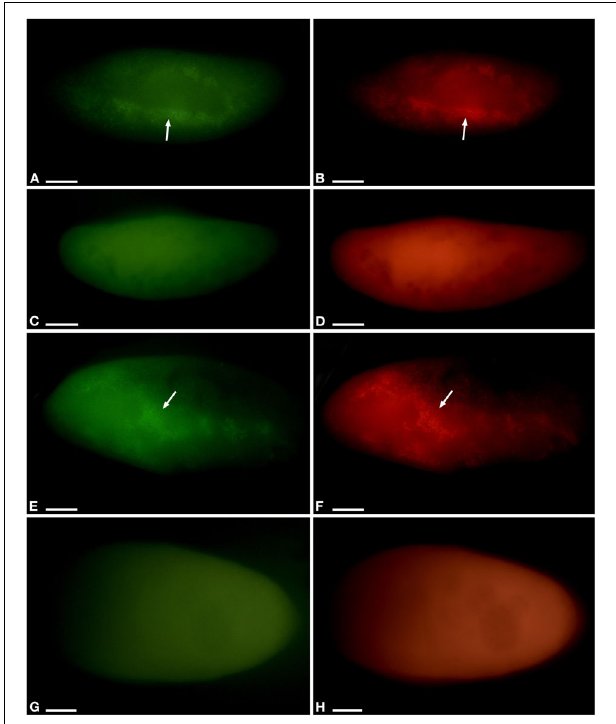
FIGURE 4 | Fluorescent in situ hybridization of Paramecium pentaurelia YE9 (A–D) and Paramecium primaurelia LgJac (E–H) . Examples for an infected cell (A,B,E,F) and one that had spontaneously lost Ca . Megaira polyxenophila (C,D,G,H) at 4.5 ppt 17 days after the beginning of the growth experiment, using the universal bacterial probe EUB338 specific for 90% of known bacteria (A,C,E,G) and Megenus_487 specific for Ca . Megaira (B,D,F,H) . Arrows indicate Ca . M. polyxenophila in the host’s cytoplasm. Scale bar = 10 µ m.